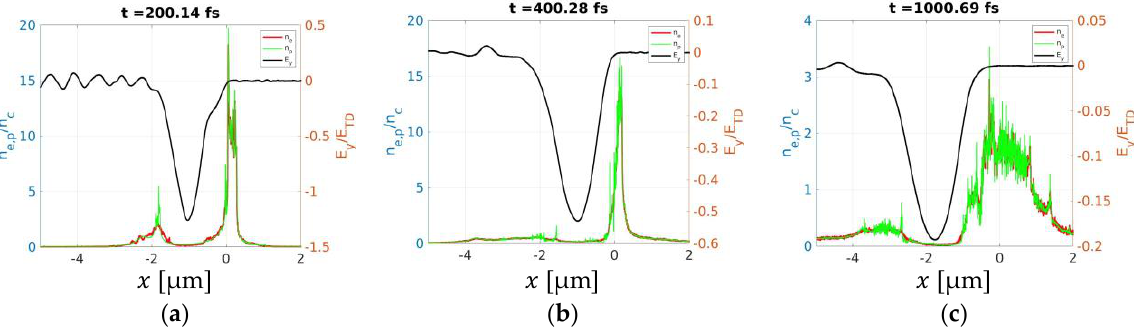
Figure 4. Snapshots of the spatial profiles of the electron density (red), proton density (green) and transverse electric field (black) at 200 fs, 400 fs, and 1000 fs respectively for 𝑎 0 = 1 laser for the case of the over-dense foil and tailor region. The laser pulse penetration of the trapping region is similar to Figure 3 with Figure 3c taken at same time as ( a ) shows the electrons and the ions are expelled from the region of the maximum trapping. The evolution of the half-cycle proceeds ( b ) with no laser field penetration beyond the foil. The overdense foil prevents the transmission and thus enhances and facilitates the laser pulse trapping for long times ( c ).